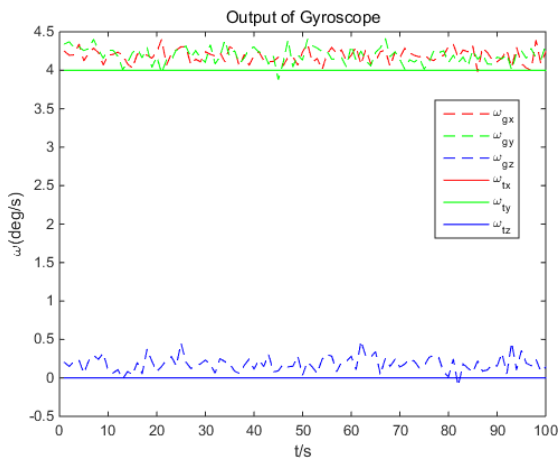
Figure 9. Simulated output data of gyroscope.